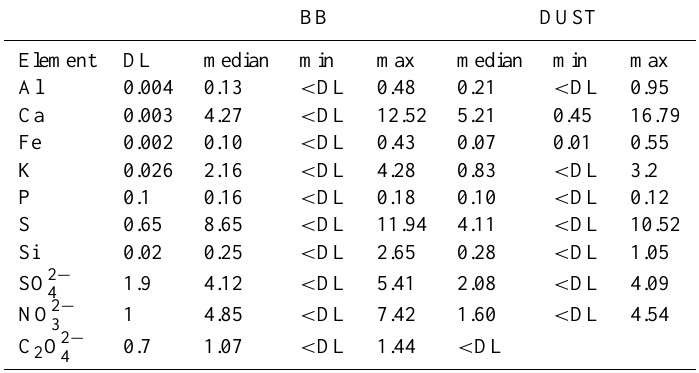
Table 2. Concentrations of dissolved species (µgm − 3 ) in the water-soluble fraction of BB and DUST samples. (DL: Detection Limit are calculated as the minimum dissolved mass measured on a filter for a mean sampled air volume of 2m 3 ).